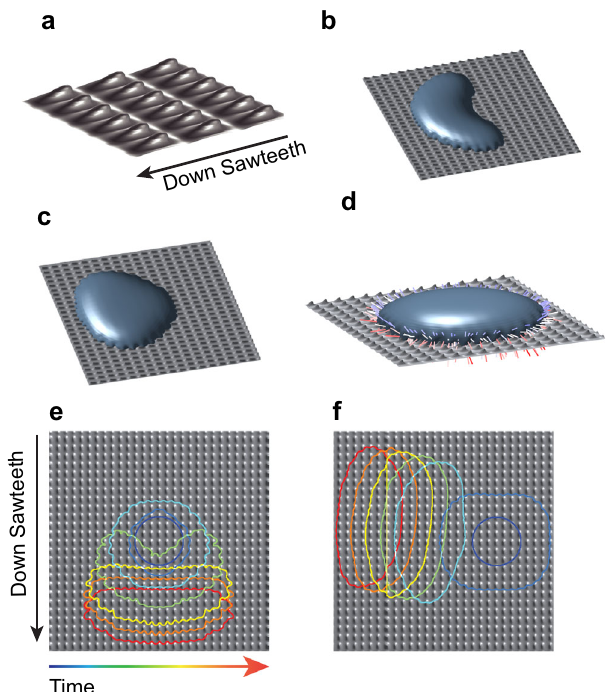
Fig. 1 Asymmetric sawteeth and dominant phenotypes. a Zoomed-in schematic of the array of asymmetric sawteeth used in the phase- fi eld model. Multiple cell-shape phenotypes are observed, including ( b ) crescents and ( c ) wedges. d Polarization vector fi eld of a cell moving down the sawteeth. The polarization vector fi eld indicates the directions of the actin polymerization and the membrane pushing force. The color denotes the strength of the polarization ( p ), with blue being the weakest and red being the strongest. All polarization vectors point out of the cell. The asymmetric sawtooth nanotopography can cause the cell to polarize spontaneously ( e ) either down the sawteeth or ( f ) perpendicular to the